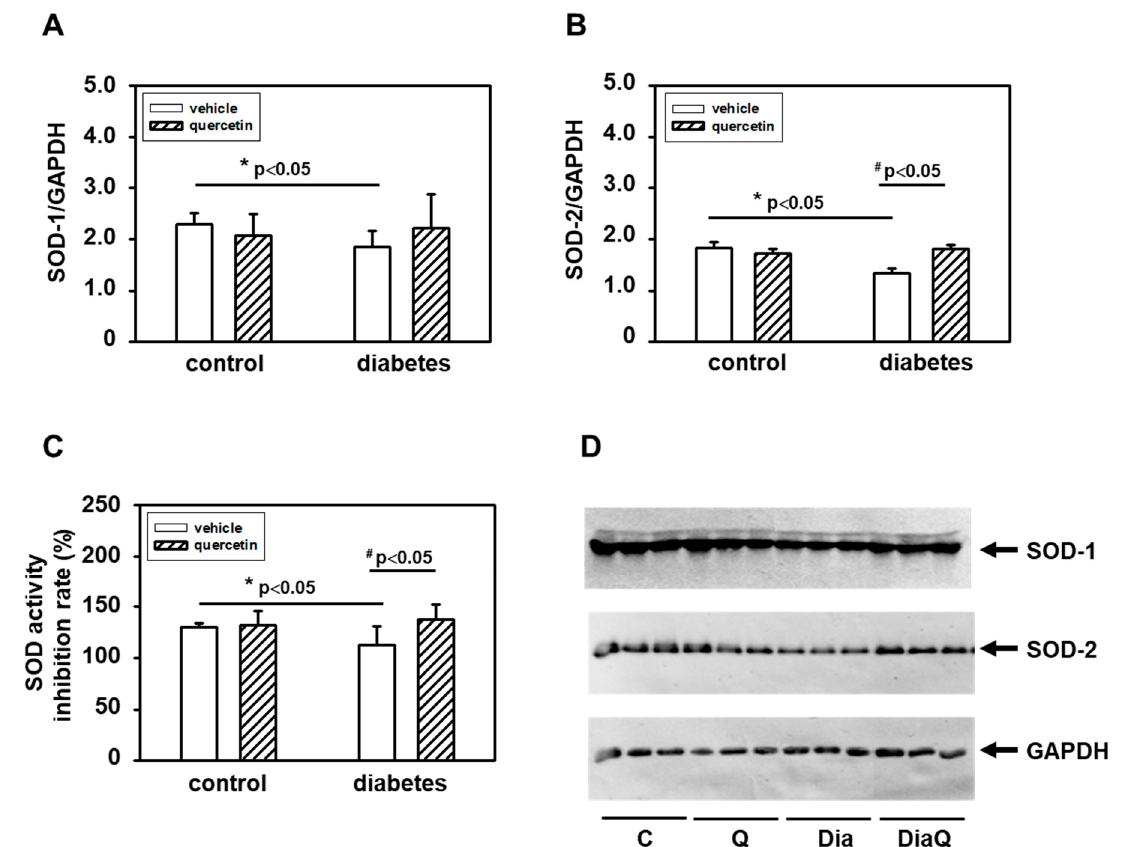
Figure 6. Effects of quercetin on superoxide dismutase (SOD) protein levels and activities in left ventricular tissue of control lean and obese diabetic Zucker Diabetic Fatty (ZDF) rats. ( A ) Quantification of SOD-1 protein levels. ( B ) Quantification of SOD-2 protein levels. Levels of SOD-1 and SOD-2 were determined by Western blot analysis using specific antibodies. Quantifications of SOD-1 and SOD-2 content were normalized to the glyceraldehyde 3-phosphate dehydrogenase (GAPDH) protein levels. Each bar represents mean ± SEM, n = 6–7. Statistical significance was revealed by Student’s unpaired t -test, * p < 0.05 vs. control lean vehicle-treated rats, # p < 0.05 vs. obese diabetic vehicle-treated rats. ( C ) Effects of quercetin on SOD activities. SOD activities were determined using SOD colorimetric assay kit (Abcam) in cytosolic fractions isolated from the left ventricular tissue ( n = 6–7). The data represent the percentage inhibition of superoxide production by SOD activity. ( D ) Western blot records showing the changes in protein levels of SOD-1, SOD-2, and GAPDH. C—control lean vehicle-treated ZDF rats; Q—lean quercetin-treated ZDF rats; Dia—obese diabetic vehicle-treated ZDF rats; DiaQ—obese diabetic quercetin-treated ZDF rats.